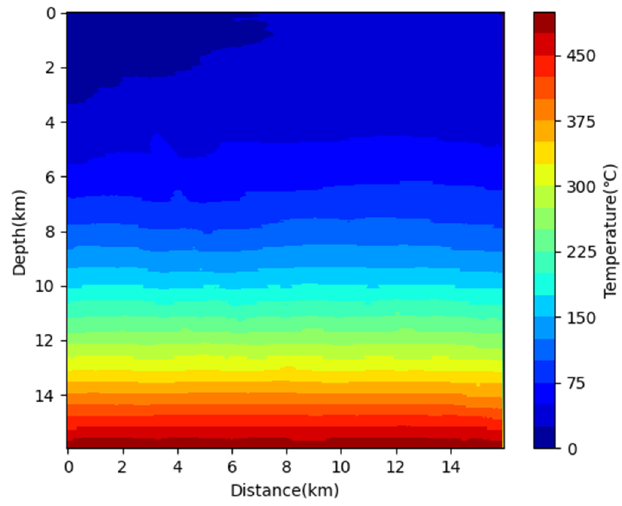
Figure 14. Temperature field of complex model simulated from HDRT − UNet.